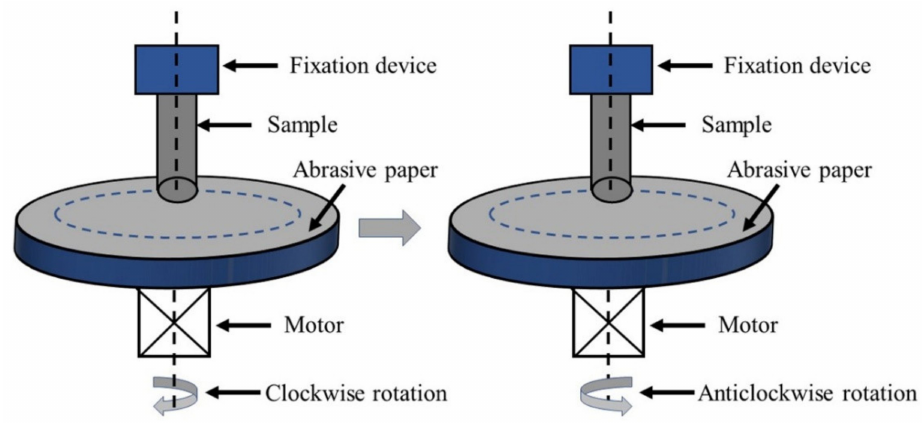
Figure 2. Schematic of friction and